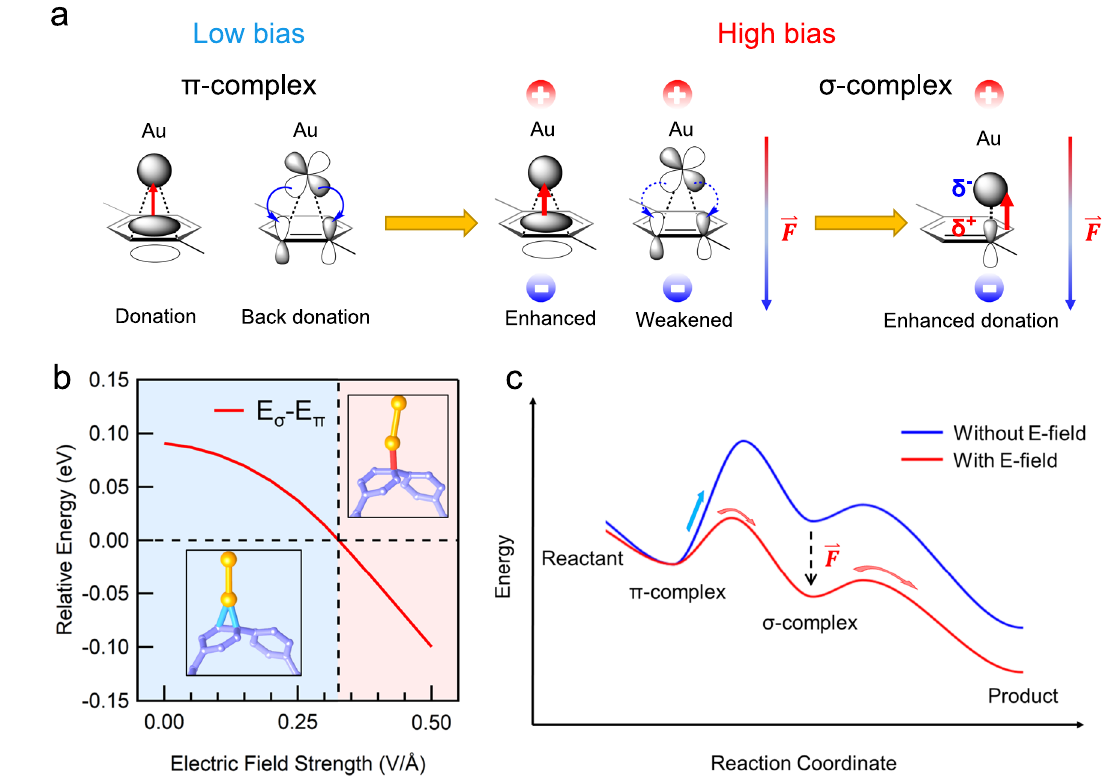
Fig. 5 | Proposed mechanism of OEEF-catalyzed EAS. a Electric fi eld effect on orbitalinteractionsbetweenCPP molecule and Au. b Relative energy of π -complex and σ -complex against the strength of OEEF, where E σ is the energy of σ -complex, and E π is the energy of π -complex. (See Supplementary Fig. 17 for the